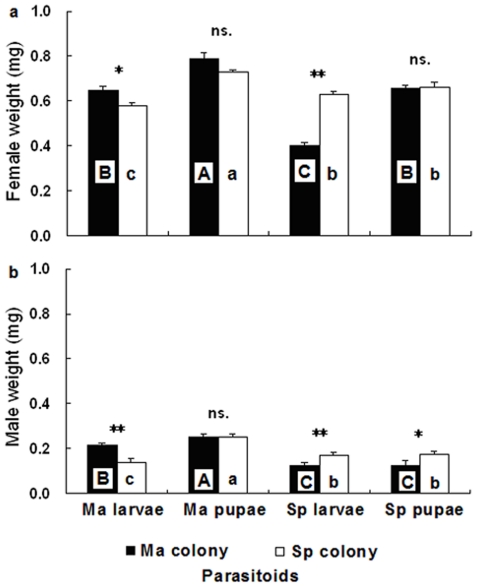
Offspring weight of Sclerodermus harmandi from different culturing systems on two development stages of hosts: (5a) adult females, (5b) adult males.Same alphabets on columns indicate no significant differences (P<0.05). For abbreviations see Figure 1 (Mean±SE, n = 300 females, 200 males in each treatment, ** P<0.01, * P<0.05 and ns. P>0.05).